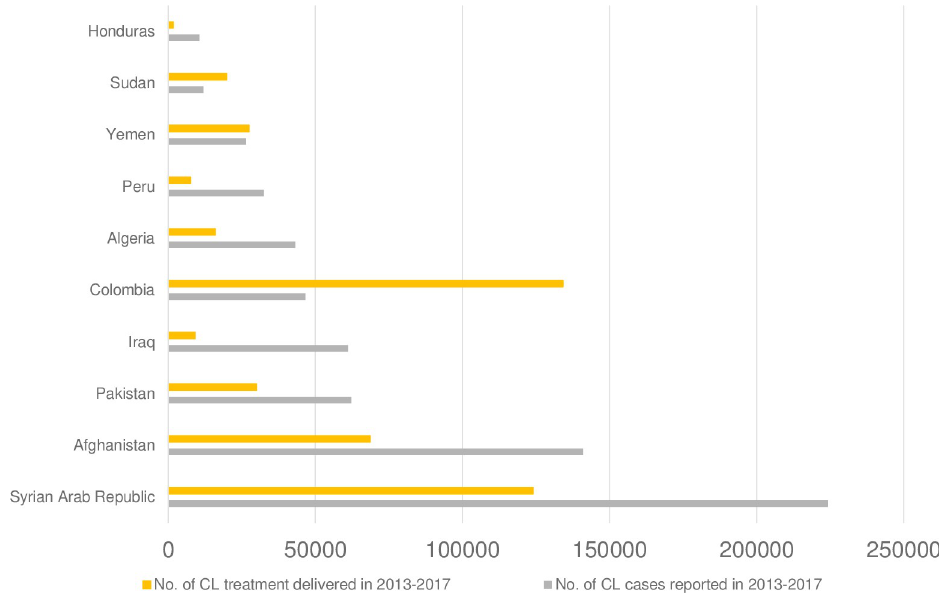
Fig 3. Supply and demand in top 10 CL countries, 2013–2017. CL: cutaneous